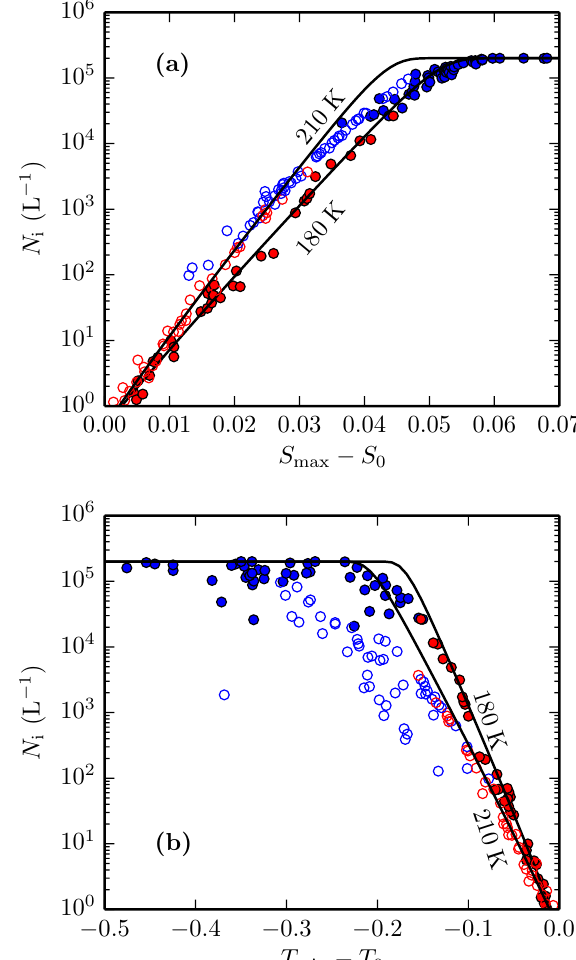
Figure 7. Number of ice crystals nucleated at T 0 = 195K for α = 0 . 1 using the balloon temperature perturbation time series. Blue circles show vapour-limit nucleation events. Red circles show temperature-limit nucleation events. The solid curves are obtained from Eqs. (14)–(18) with µ = 0 . 05s − 1 .